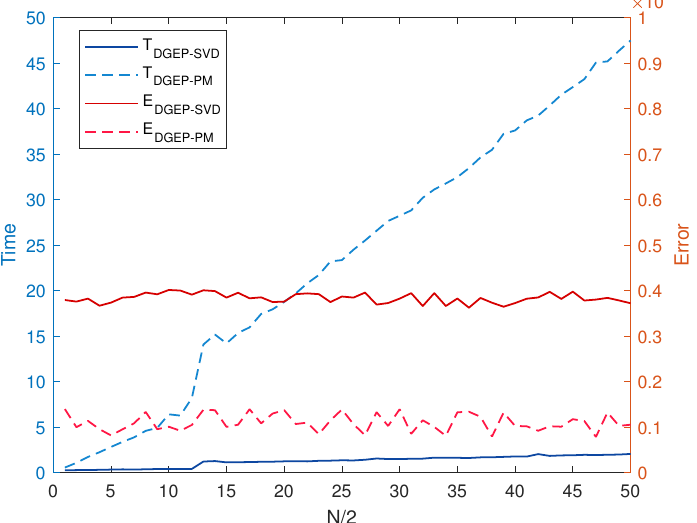
Figure 3. Performance of DGEP-SVD and DGEP-PM in running time ( T / s ) and error ( E ) with respect to the number of local severs ( N